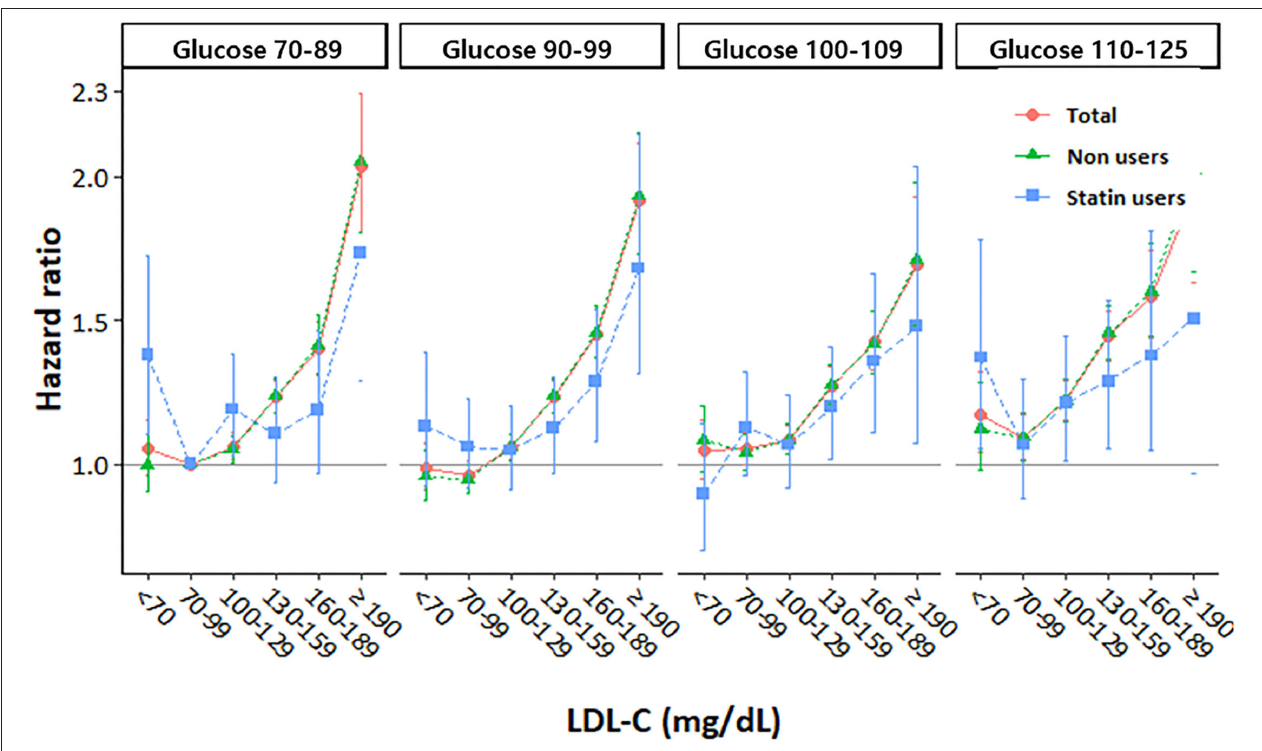
FIGURE 2 | Hazard ratios for cardiovascular disease according to LDL cholesterol levels stratified by fasting glucose level at